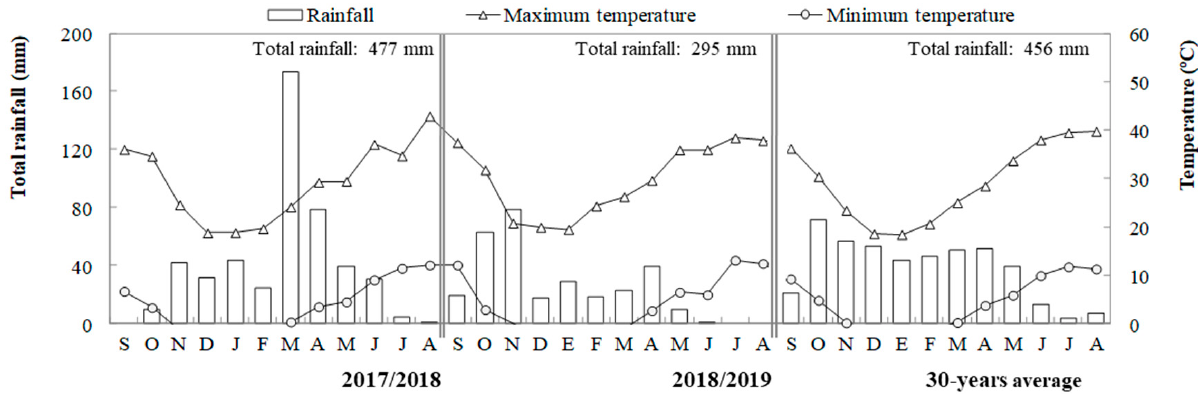
Figure 6. Monthly and annual rainfall and mean maximum and minimum temperatures in 2017/2018, 2018/2019 and in an average year from a 30-year period in Badajoz (Spain).